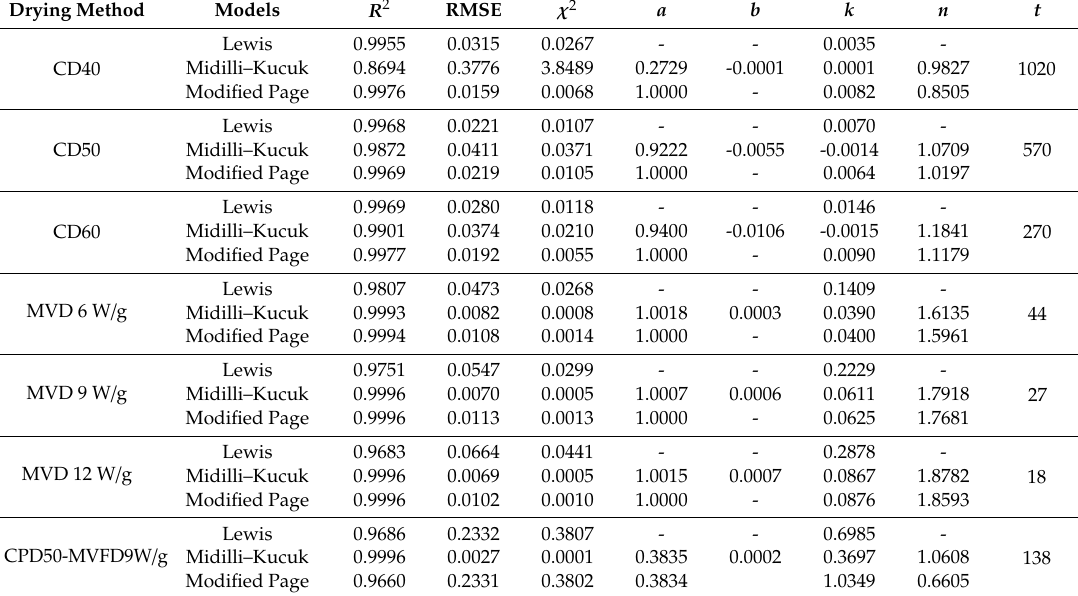
Table 2. Drying time, statistical parameters and model constants describing the drying kinetics of Muraya koenigii